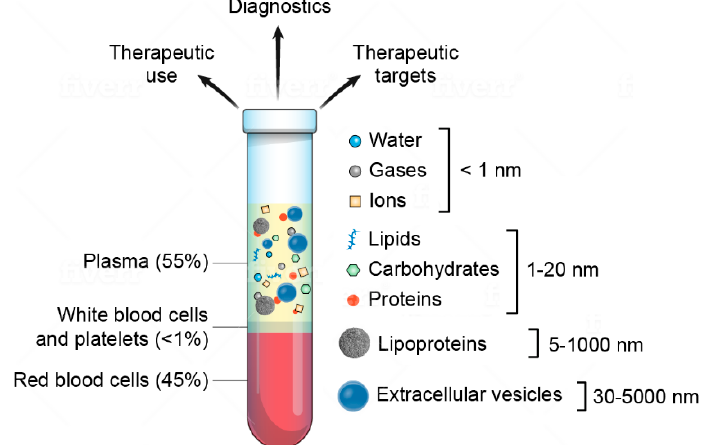
Figure 1. Schematic of blood content, highlighting plasma components. Components are not drawn to scale.